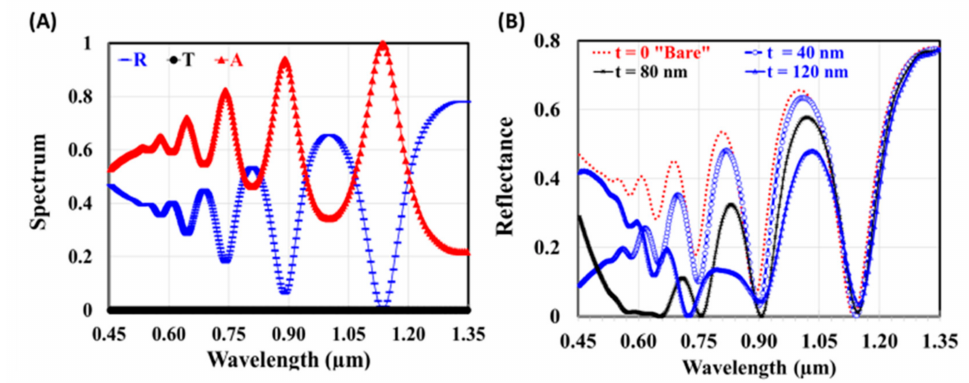
Figure 2. ( A ) Transmittance, reflectance, and absorbance of bare conventional GaAs Scheme (40 nm, 80 nm, and 120 nm); ( B ) Reflectance GaAs solar cell with antireflection coating at different ITO thickness.